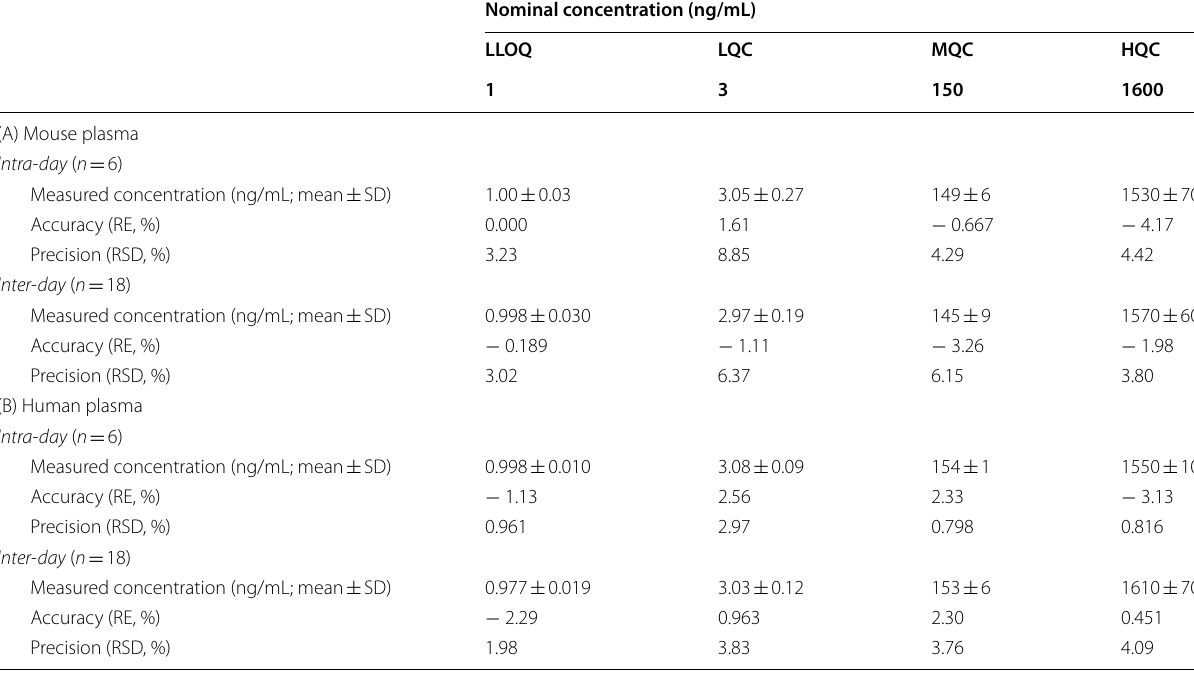
RE, Relative error, calculated as (calculated concentration as standard deviation of concentration/mean concentration